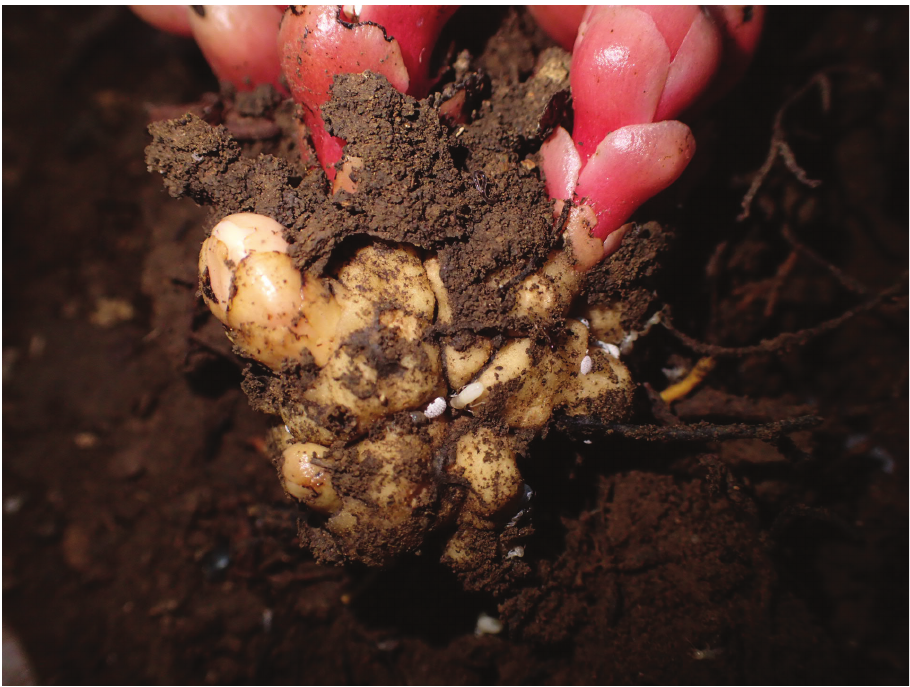
Figure 1. Live individuals of Formicoccus yoshinoi Tanaka, sp. nov. feeding on the underground part of the host plant, Balanophora fungosa